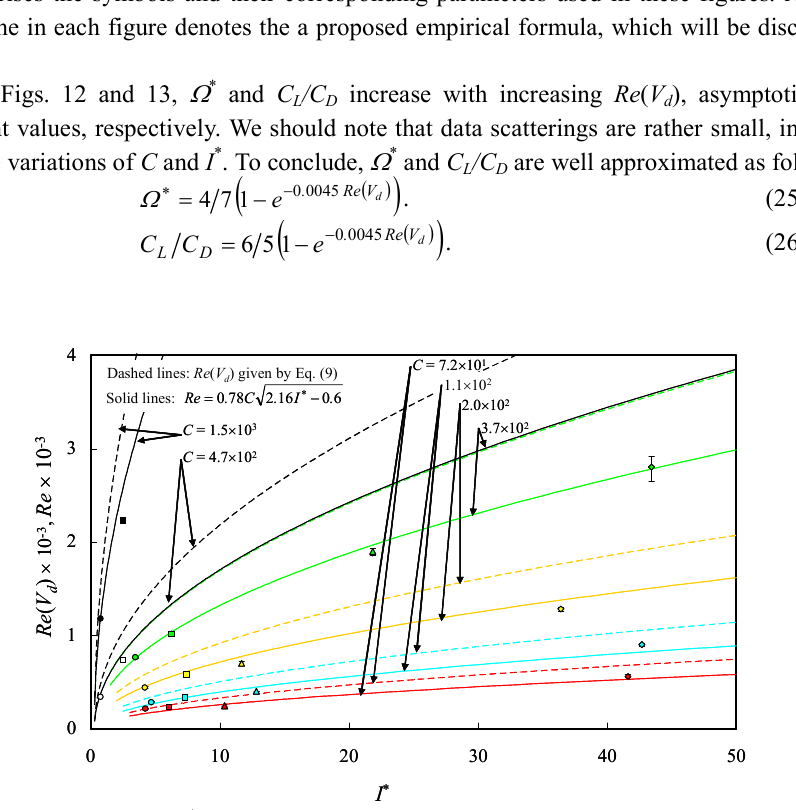
Fig. 10 Relation between I * and the Reynolds number Re ( V d ) based on V d for six constant values of C , together with Reynolds number Re versus inertia moment ratio I * , for λ = 0.3, AR = 10, C = 7.2 × 10 1 − 1.6 × 10 3 and I * = 0.75 − 43.